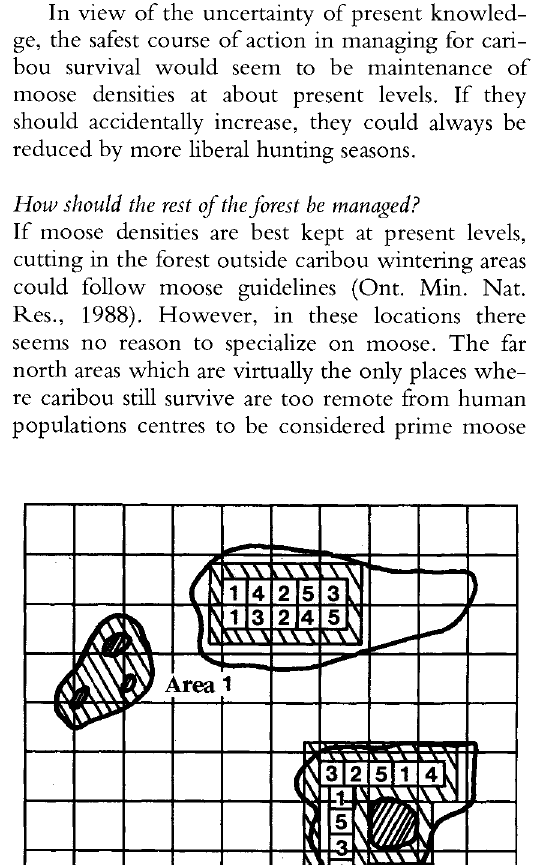
Fig. 2. Proposed forest management strategy for winter caribou refuges in partitioned habitat. Area 1 is a complex of small currently used wintering areas with a 3 km buffer; since no adjacent potential sites are available, replicated operations-level tre atments for stand renewal are carried out on a nearby area (numbered small squares represent treatments or controls). Area 2 is a single current ly used wintering area surrounded by a larger potential area with treatments; numbers represent same treatments as in Area 1 to allow determina tion of within-site and between-site